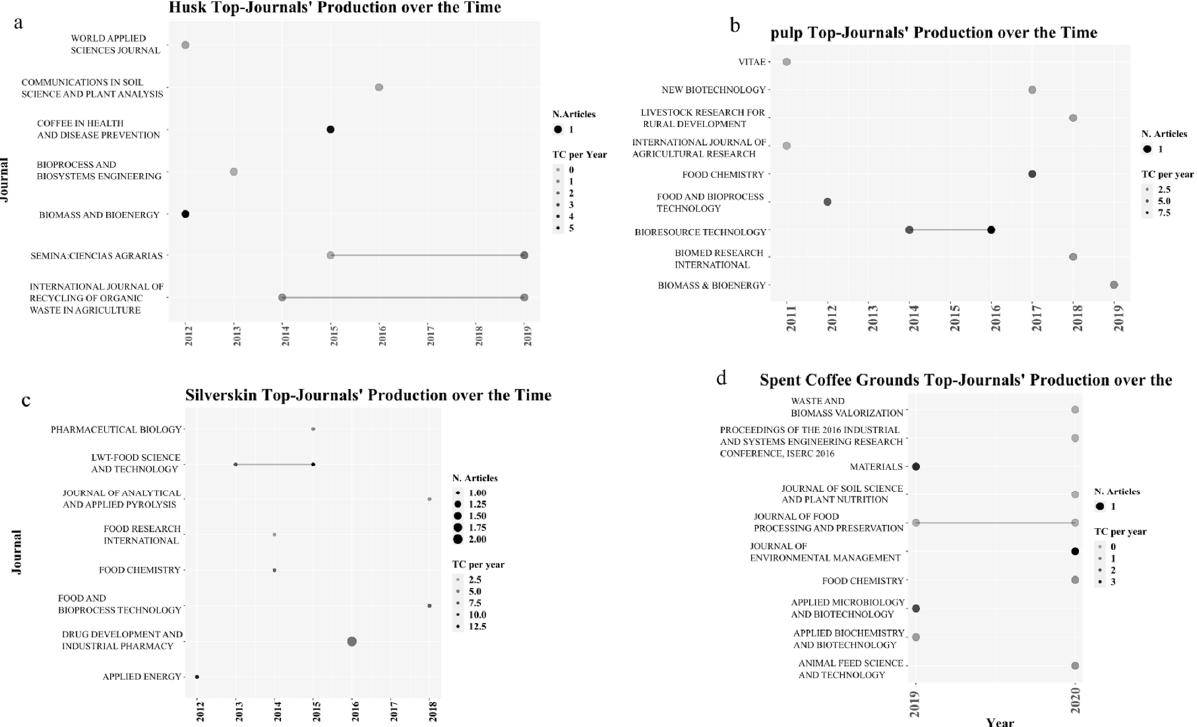
Figure 5. Journal production of each coffee by-product over time: ( a ) CH, ( b ) CP, ( c ) CS, ( d ) SCG.